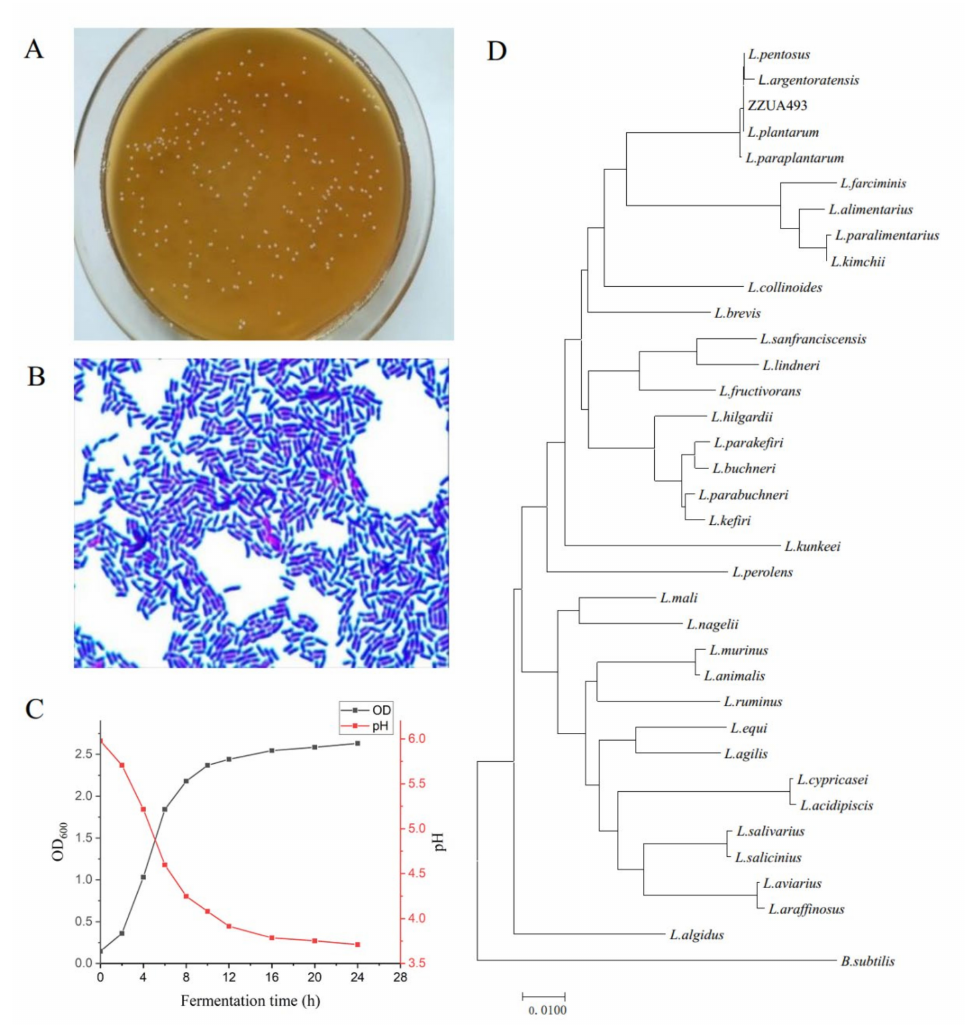
Figure 3. Identification of ZZUA493 strain. Colony morphology ( A ); gram staining ( B ); growth and pH change curve of ZZUA493 ( C ); phylogenetic tree obtained from 16Sr RNA gene sequence analysis, giving the genus of ZZUA493; the tree was generated by the neighbor-joining method and the bar shows 1% sequence divergence ( D